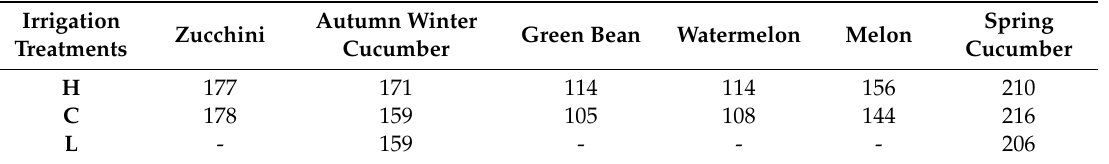
Table 2. Total irrigation water supply (mm) to the greenhouse vegetable crops grown under high (H), conventional (C) and low (L) soil water availability